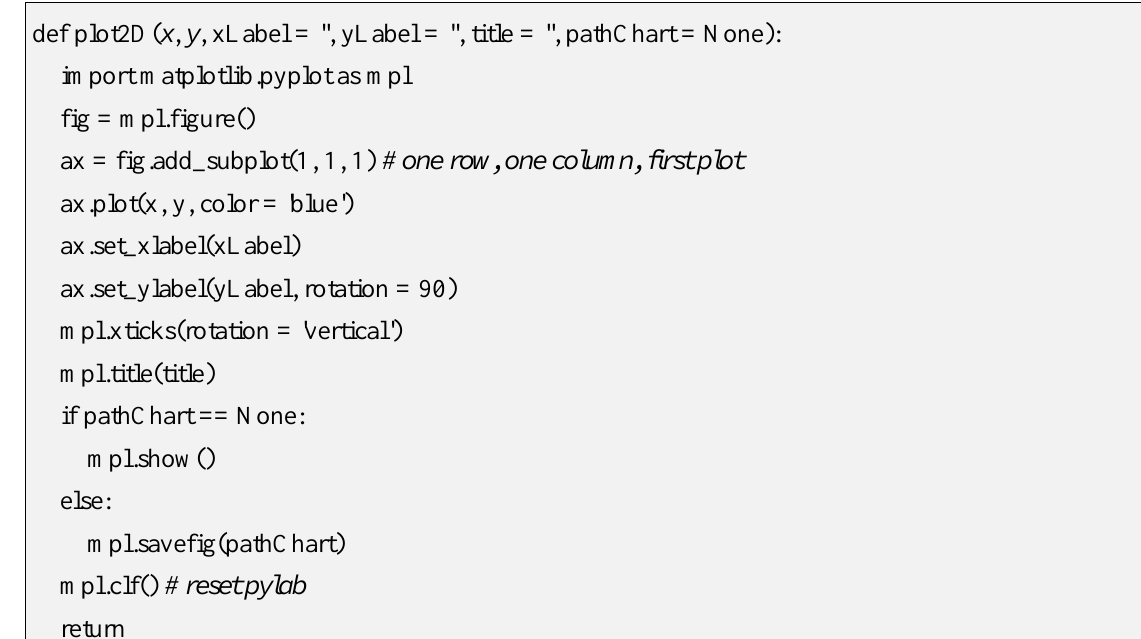
ax = fig.add_subplot(1, 1, 1) # one row, one column, first plot ax.plot(x, y, color =